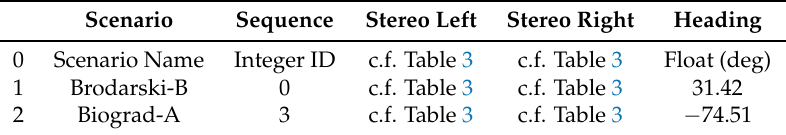
Table 5. Header/column fields for diver heading database. Row 0 describes the data fields, Row 1 and Row 2 show